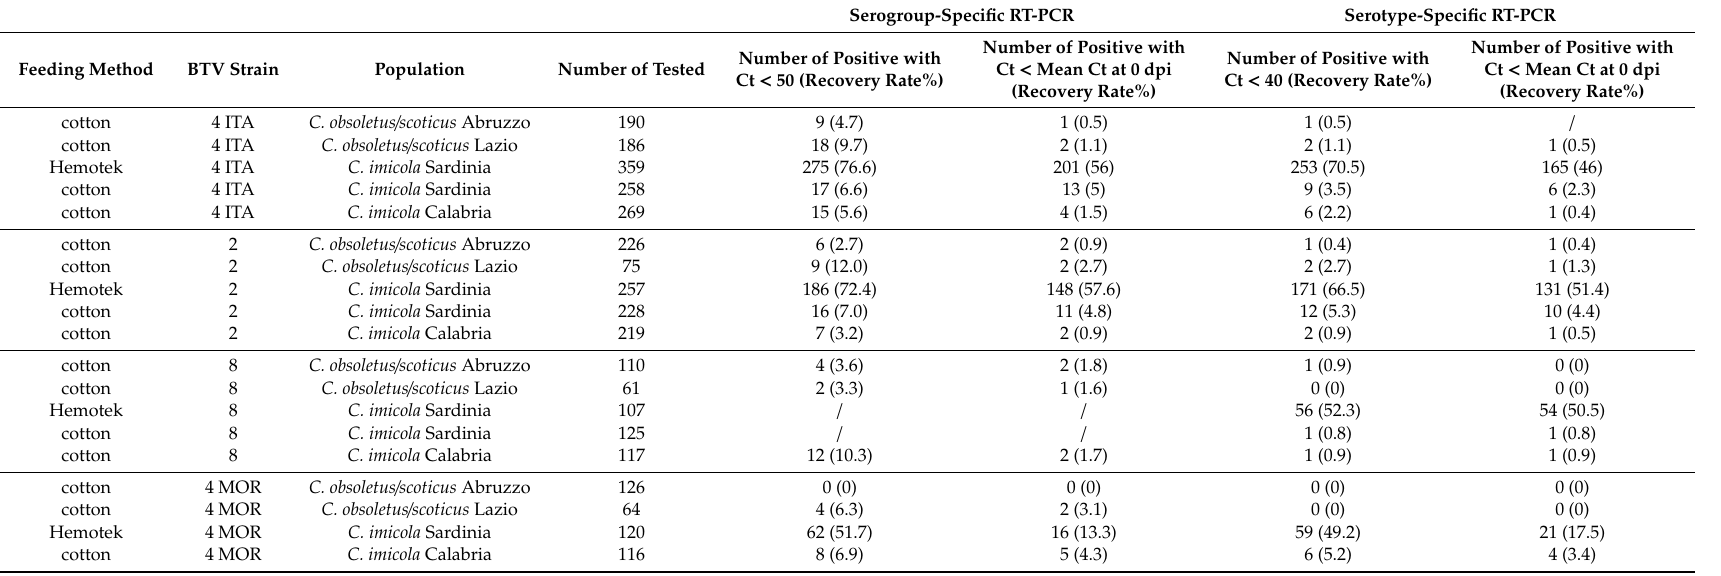
Table 5. Recovery rates of bluetongue virus strains from di ff erent Italian vector populations orally infected according to di ff erent RT-PCR cut-o ff